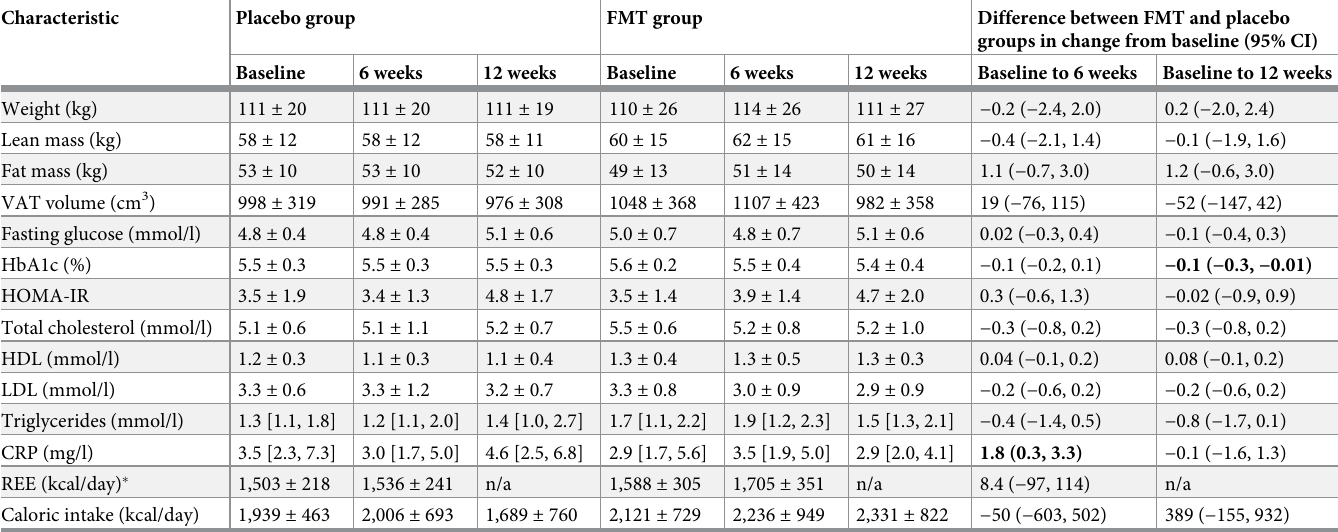
Table 2. Metabolic parameters in FMT and placebo groups throughout the 12-week